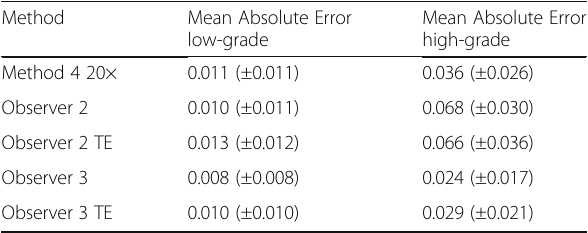
Table 3 Observer and sampling error evaluation results